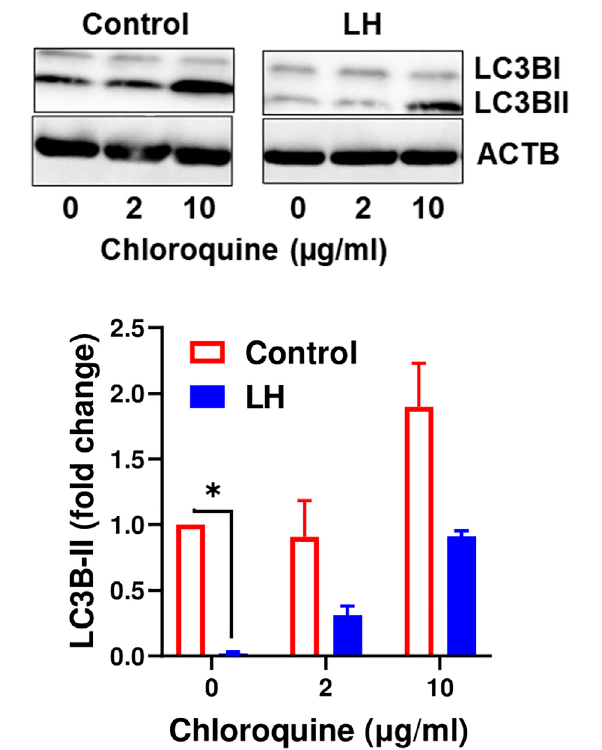
FIGURE 7 | LH inhibits formation of autophagosomes. Cultures of small luteal cells were pretreated with chloroquine (2 and 10 μ g/ml) for 1 h and then treated with LH (10 ng/ml) for 4 h. Representative blots and bar graphs show content of LC3B. Data are shown as average fold changes ± SEM from threeseparateexperiments.Statisticalanalysiswasperformedusingone-way with post hoc Bonferroni test. Signi fi cant differences are indicated with asterisks * as p <